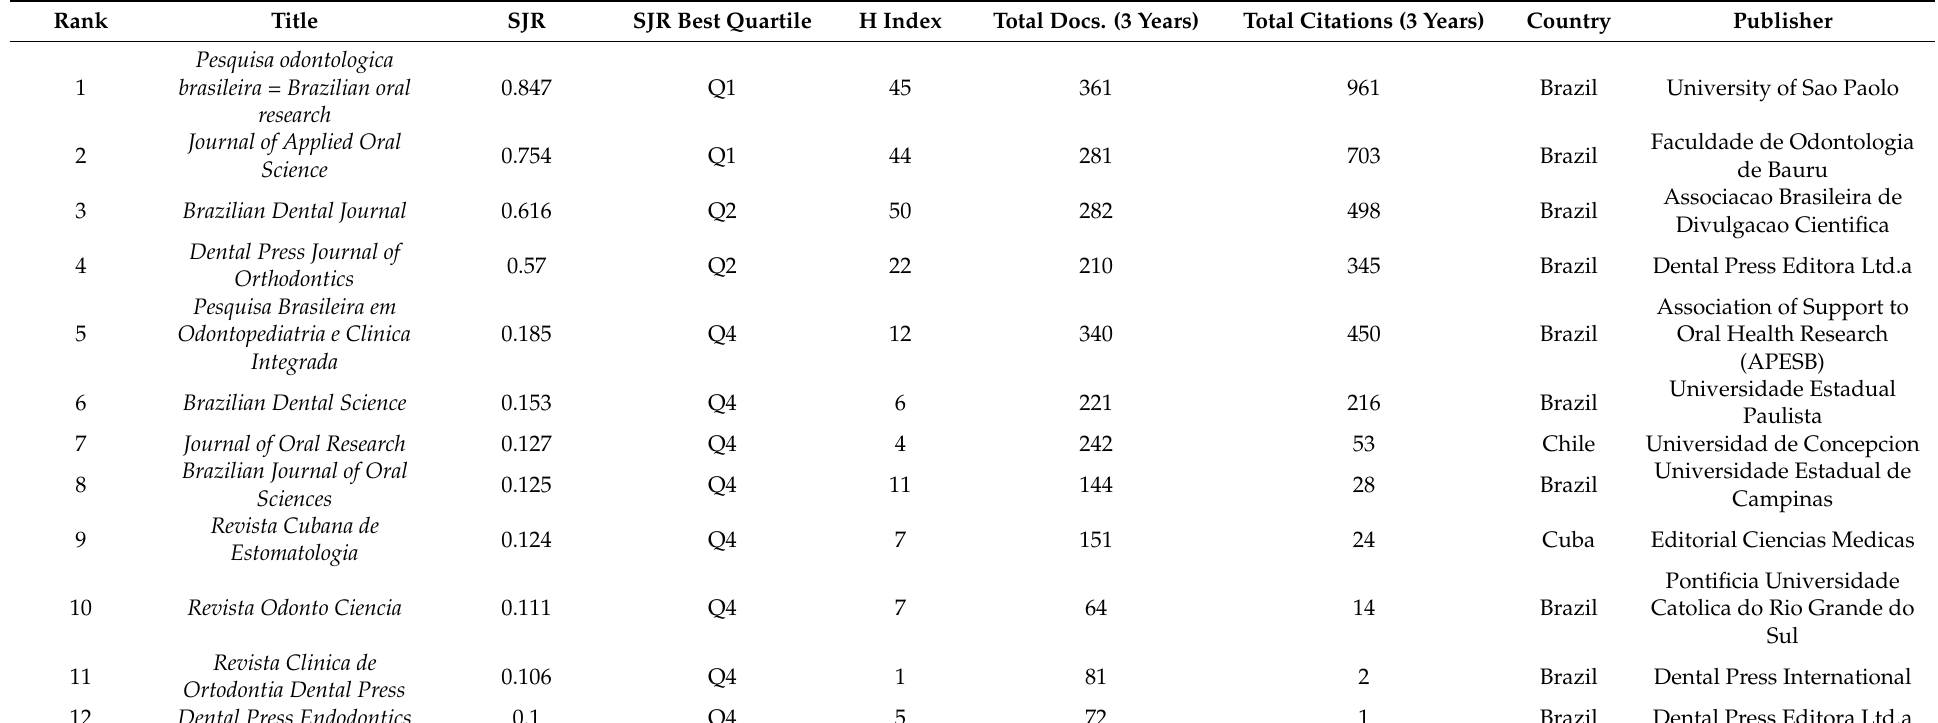
Table 3. Latin American Journals in the Dentistry Area